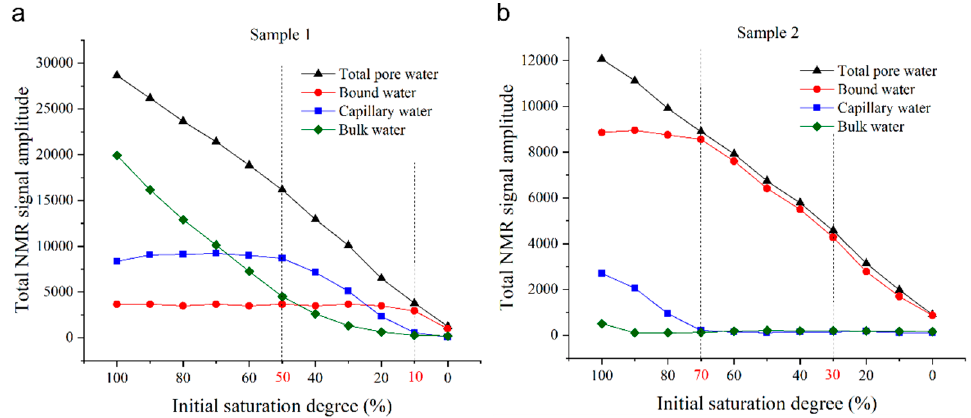
Figure 5. Variation in the contents of different types of pore water with rock saturation degree in samples ( a ) 1 and ( b )